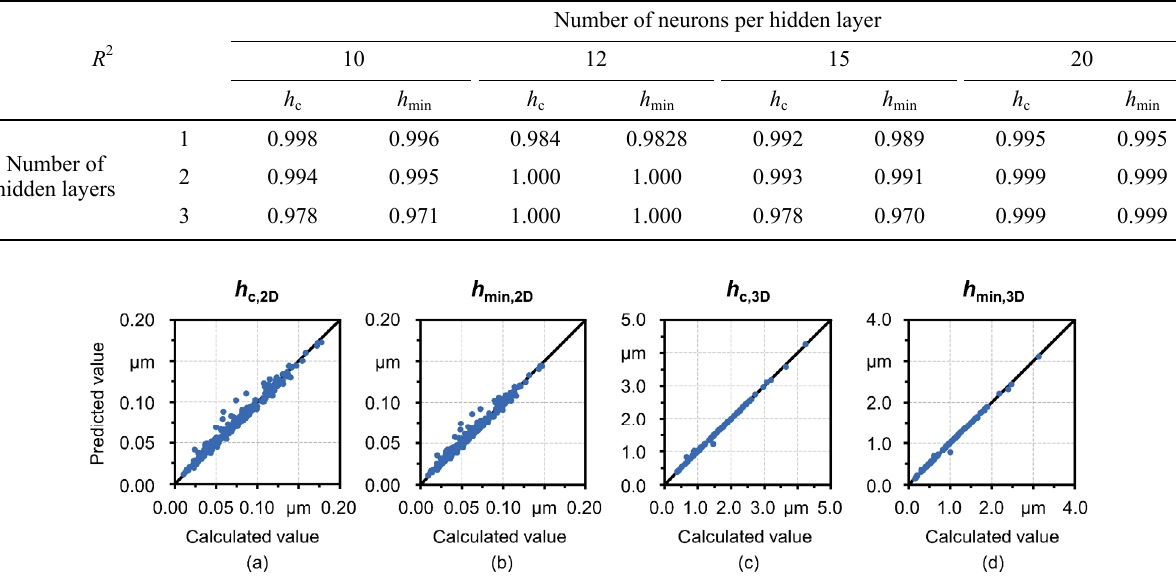
Table 8 Coefficients of determination for the prediction of the central and minimum film thicknesses for the 3D circular point contact against testing data using ANNs with variable numbers of hidden layers and neurons per hidden layer.